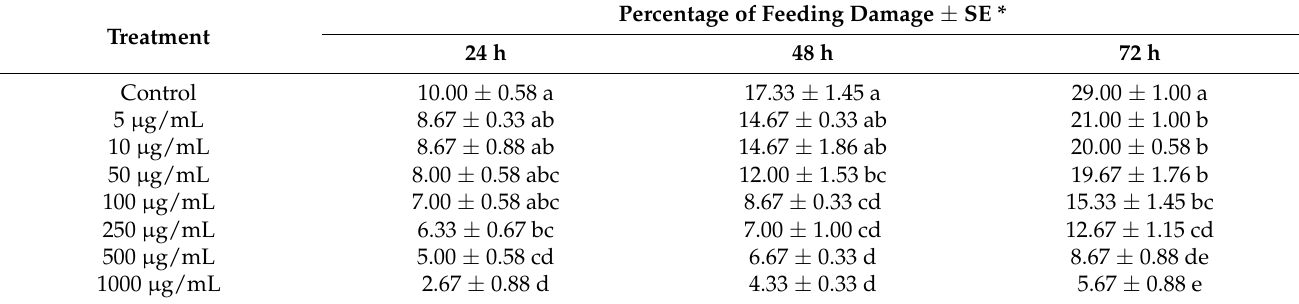
Table 3. Effects of ethanolic powdered extract of Magnolia tamaulipana leaves on Oligonychus punicae feeding damage.